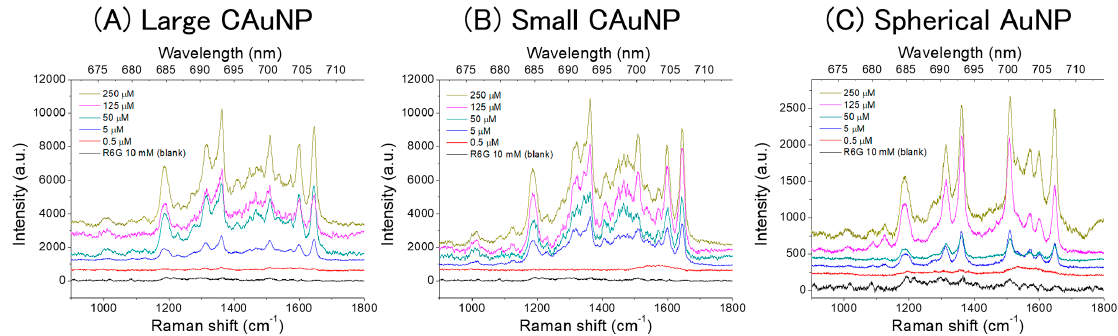
Figure 4. Raman scattering of R6G on the films of CAuNPs and spherical AuNPs. ( A ) large CAuNP, ( B ) small CAuNP, and ( C ) spherical AuNP. ( B ) small CAuNP, and ( C ) spherical